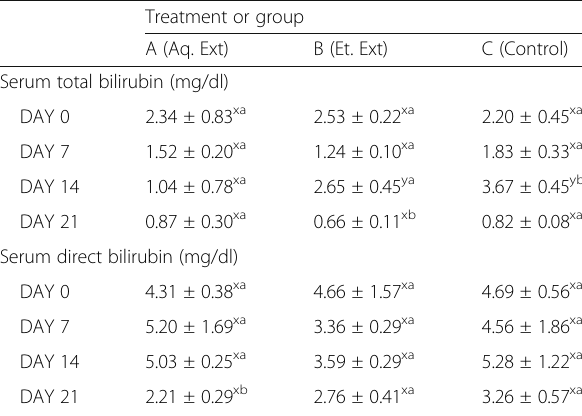
Data represent Means ± S.E.M ( n = 6). Means with different letter a, b superscripts, along column, are significantly different ( p < 0.05). Means with different letter x, y superscripts, along row, are significantly different ( p <